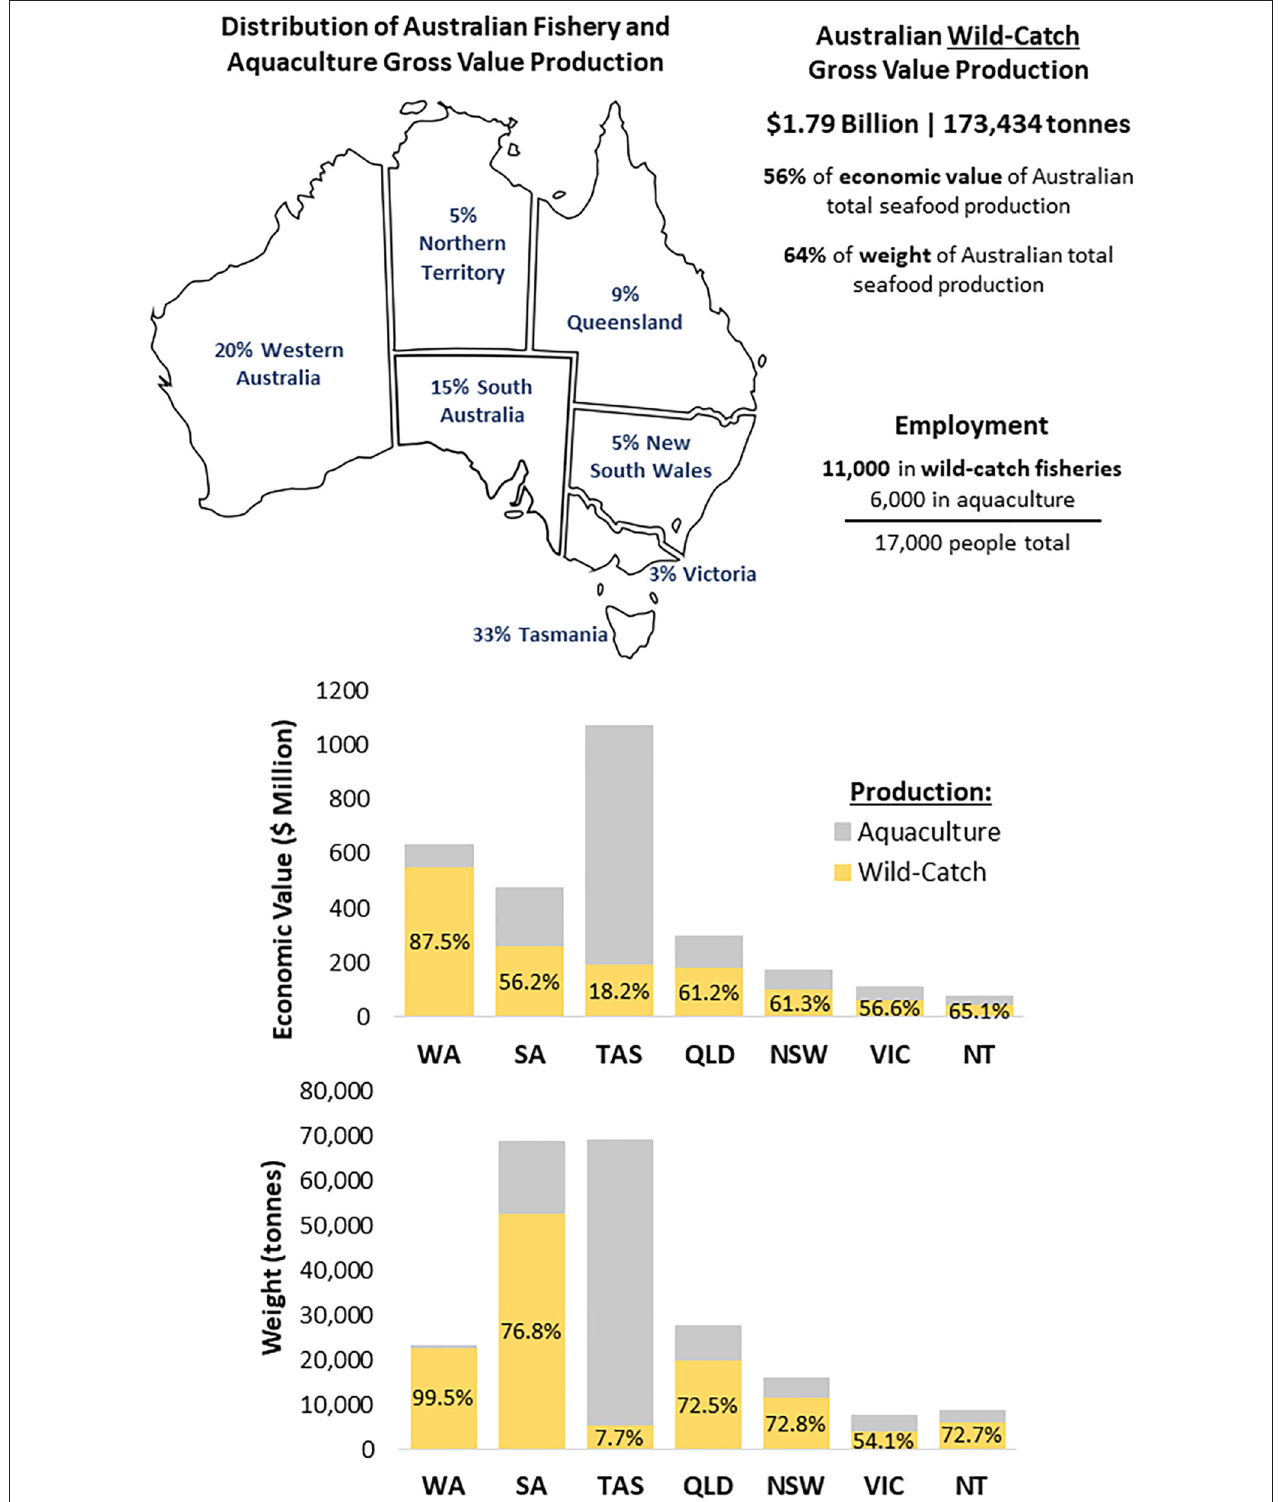
FIGURE 1 | Australian fisheries statistics for the 2017–18 fishing season, including Gross Value Production (GVP) and employment figures. Data labels over bar graphs show the wild-catch proportions of state seafood (fishery and aquaculture) production. Data from Steven et al. (2020).